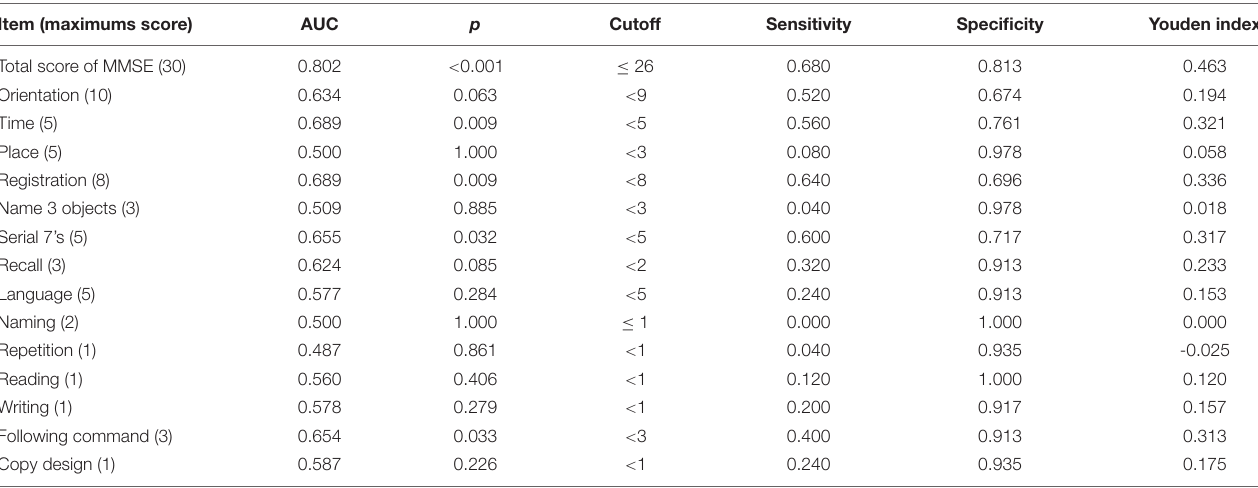
TABLE 6 | The usage of the total score of MMSE and its subtests to detect patients with PD-MCI. Item (maximums